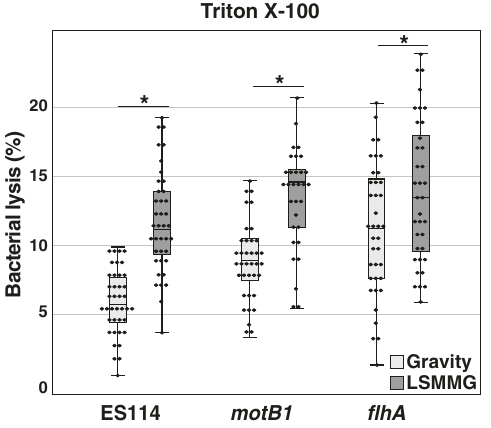
Fig. 7 Percent lysis of Vibrio fi scheri cultures following treatment with Triton X-100. The wild-type V. fi scheri ES114 and motility mutants motB and fl hA grown under gravity (light gray) and low- shear modeled microgravity conditions (LSMMG) for 12 h in response to 1 min of 0.05% v/v Triton X-100 exposure and then plated. Asterisks indicate signi fi cant differences between the data sets ( p < 0.05; Mann – Whitney U